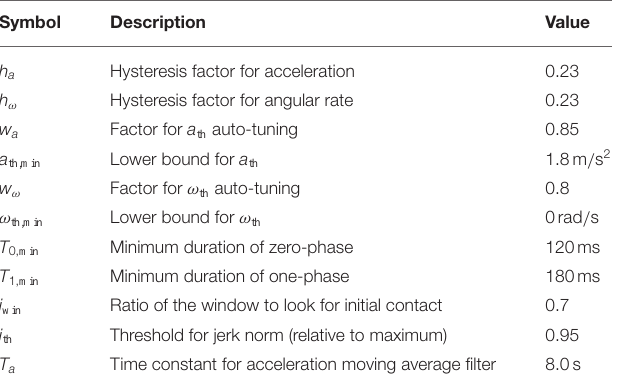
TABLE 2 | Parameter values used for the proposed IMU-based